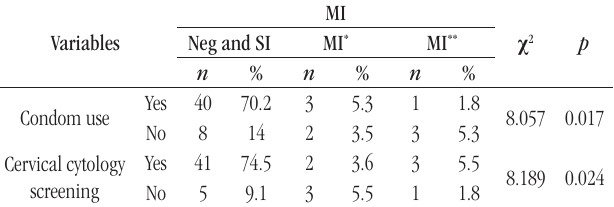
Cervical cytology screening